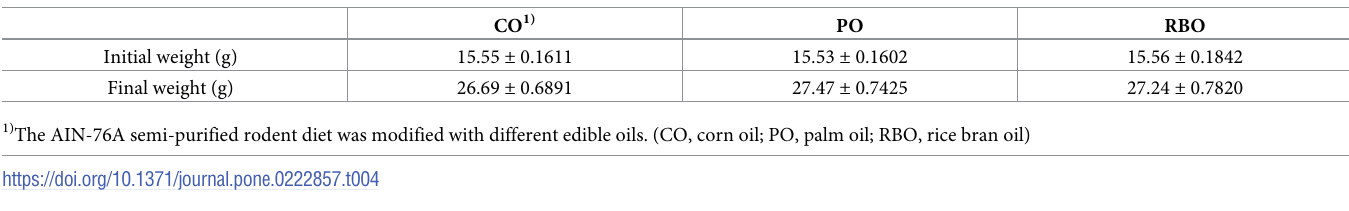
Table 4. Body weight changes following dietary